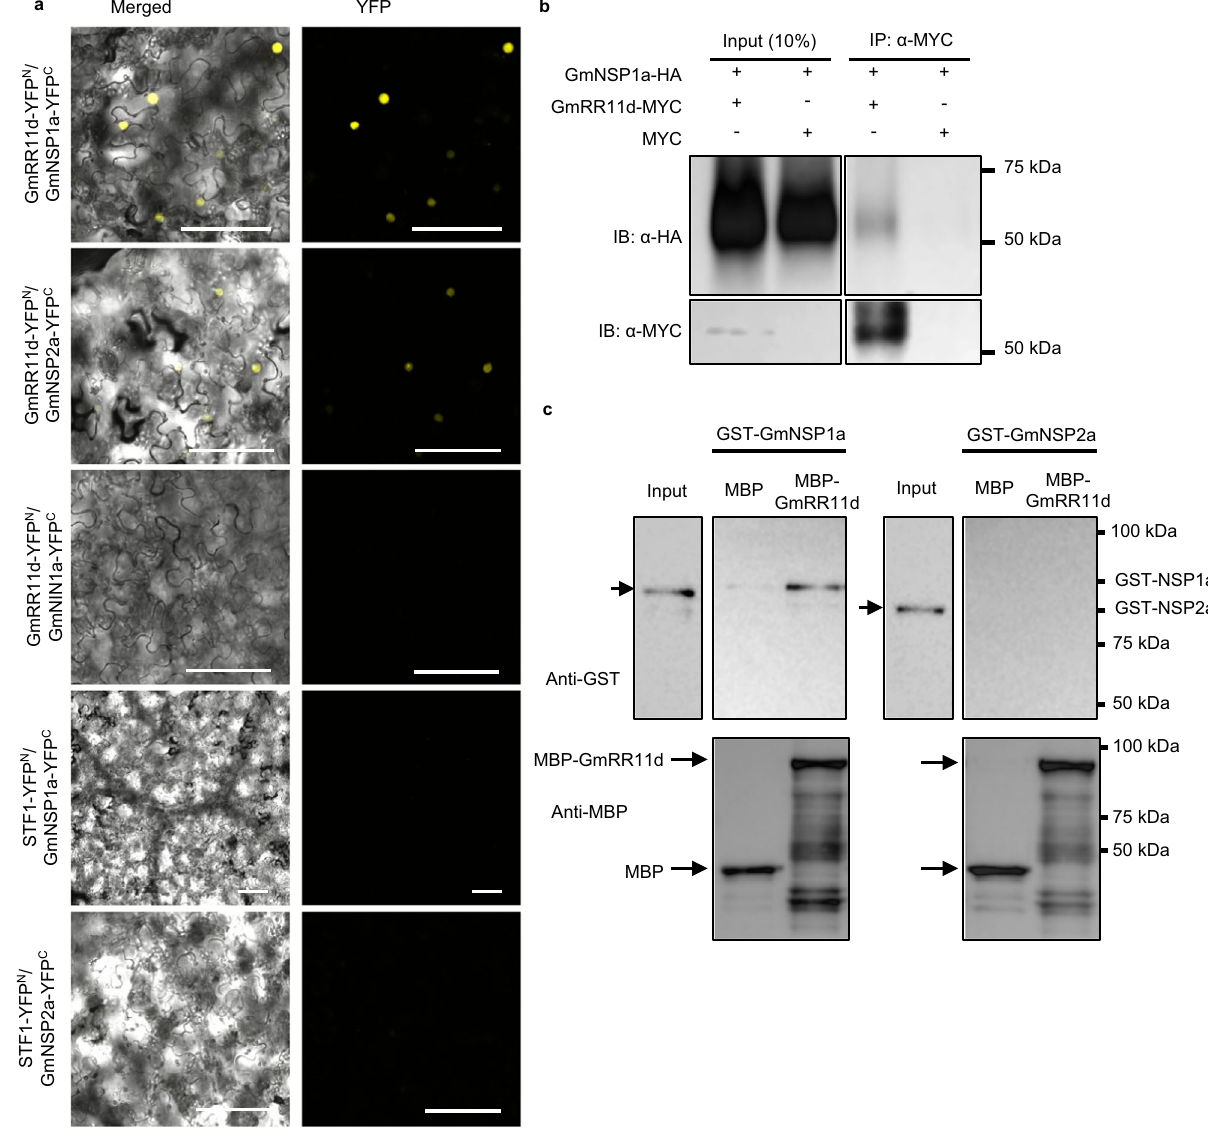
Fig. 1 | GmRR11d interacts preferentially with GmNSP1a. a BiFC assay to detect the interactions between GmRR11d and GmNSP1a or GmNSP2a. The interactions betweenGmRR11dandGmNIN1a 41 ,GmNSP1aorGmNSP2a,andSTF1 83 wereusedas negative controls. Four independent experiments were repeated with similar results. Scale bars=100 μ m. b CoIP assay of interaction between GmRR11d and GmNSP1a. GmRR11d-6xMYC (58kDa) alone or GmRR11d-6xMYC and